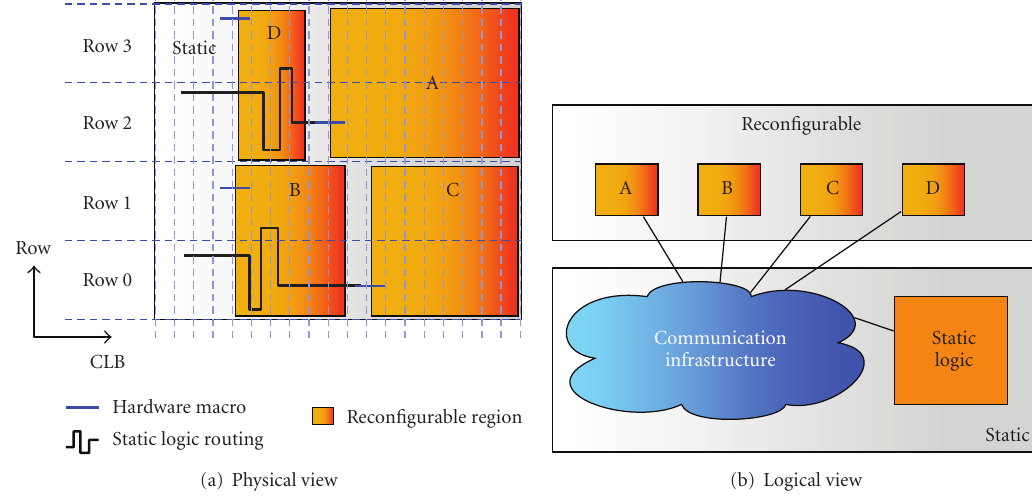
Figure 1: Target Reconfigurable Architecture based on PR: (a) physical and (b) logical